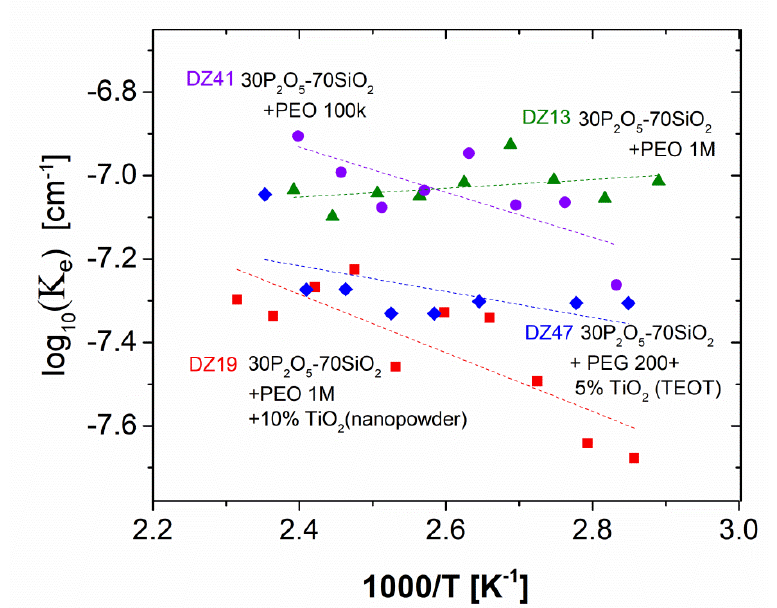
Figure 11. Jonscher’s Ke vs. temperature dependencies with reference to dielectric relaxation data compiled for the investigated series, recorded during the heating sub-cycle of PEO-doped glass compositions: (cid:78) DZ13–30P 2 O 5 -70SiO 2 + 0.5% PEO 1 M; • DZ41–30P 2 O 5 -70SiO 2 + 0.5% PEO 100 k (cid:7) DZ47–30P 2 O 5 -70SiO 2 +0.5% PEG 200 + 5% TiO (TEOT); DZ19–30P 2 O 5 -70SiO 2 + 0.5% PEO 1 M + 10% TiO 2 (nanopowder).